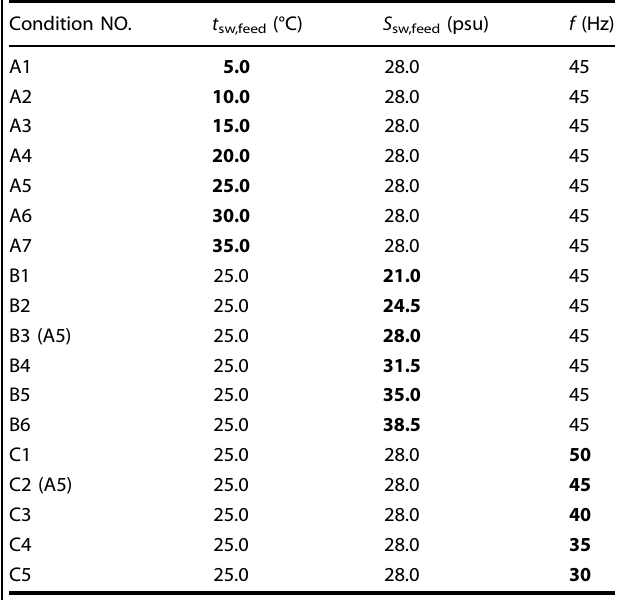
Table 3. Designed details of the experimental